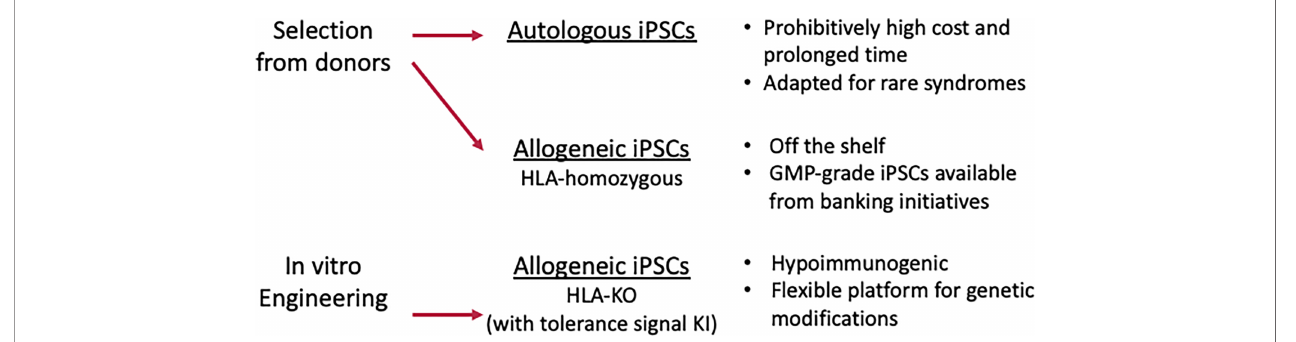
FIGURE 2 | Capability of iPSCs to provide immune-compatible